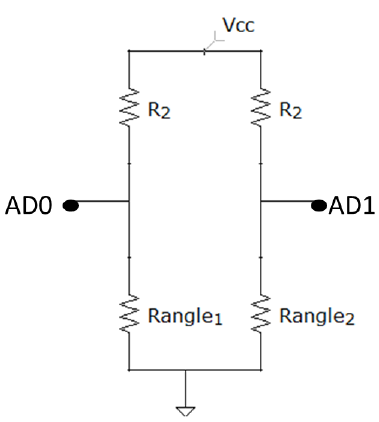
Figure 9. Bending sensors